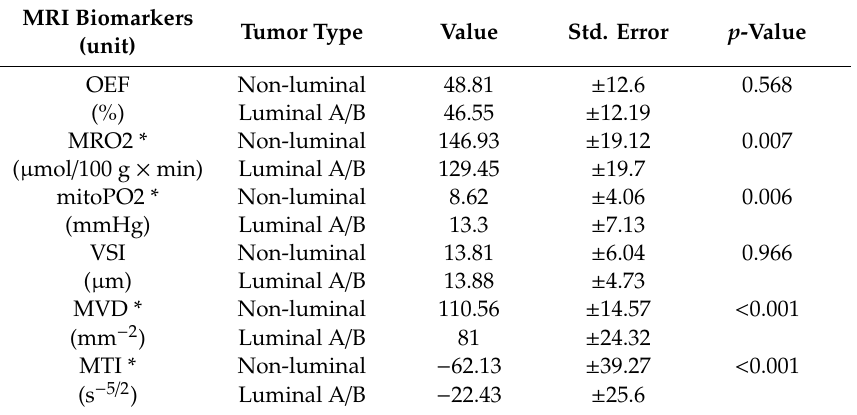
(Table 3). Hypoxia correlated with the proliferation rate and biologic aggressiveness of breast cancer as indicated by immunohistochemistry expression and distribution of common markers of hypoxia (HIF-1alpha, VEGF-C, CA IX, and FLT-1). Figures 1 and 2 exemplify CA IX staining in in a luminal B tumor and a non-luminal triple negative tumor, respectively. CA IX, a marker that is expressed only upon severe hypoxia, was strongly expressed in the fibrotic center of the TN tumor but not the luminal B tumor, representing the lower and higher mitoPO2 values seen on MRI, respectively. Table 3. MRI biomarkers and p -values for non-luminal and luminal malignancies. MRI Biomarkers Tumor Type (unit)